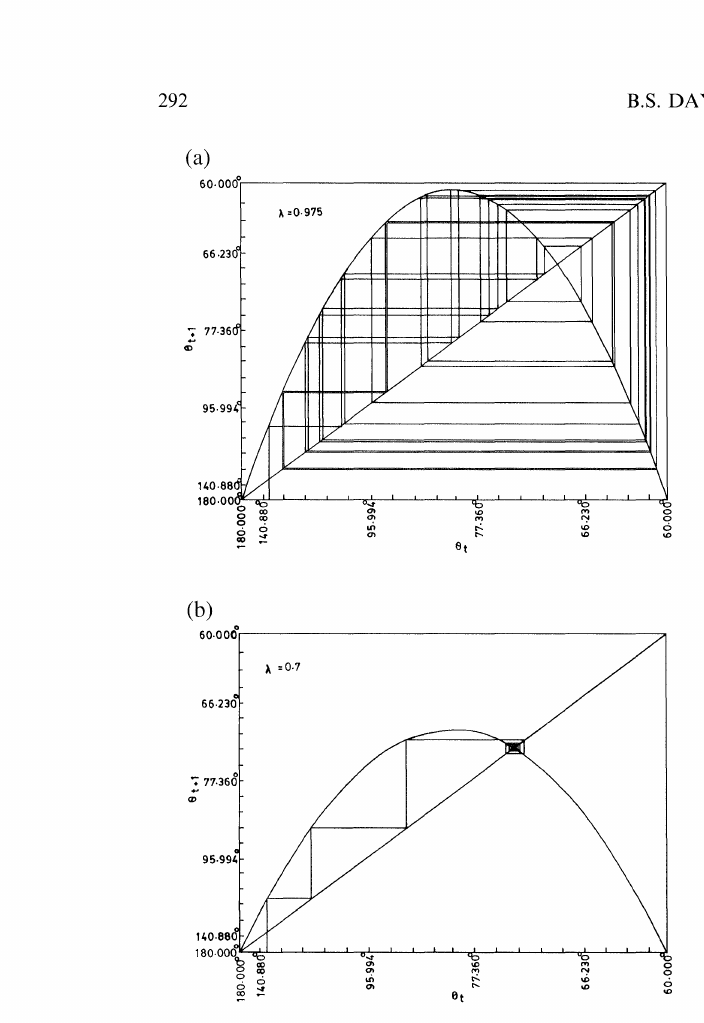
FIGURE 4 Logistic maps for the qualitative dynamical behavior of symmetric folds under evolution shown in (a) and (b). It may be seen that the values mentioned on the abscissa are IAs in degrees for the symmetric fold with three limbs. Fold Dynamical System Under the Influence of Time Dependent